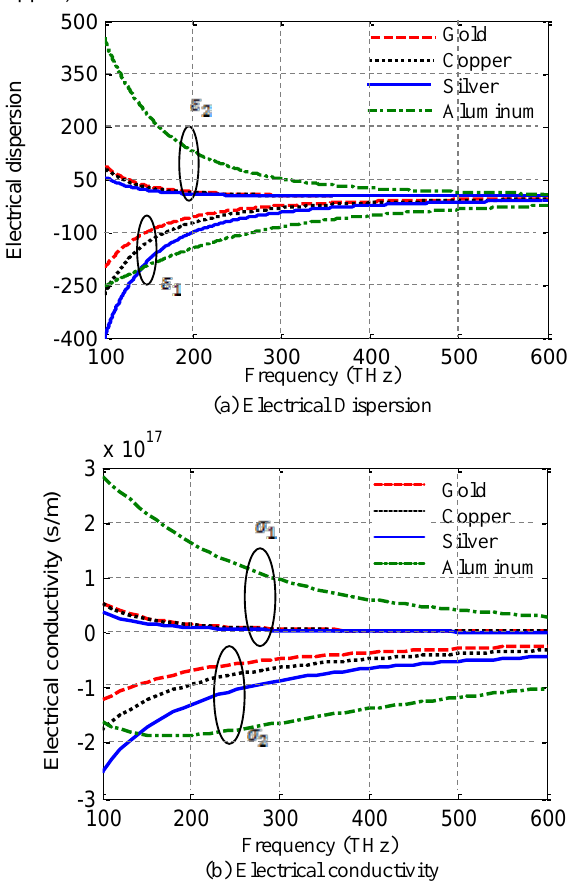
Figure 1 The variations of complex permittivity and electrical conductivity versus frequency for different types of